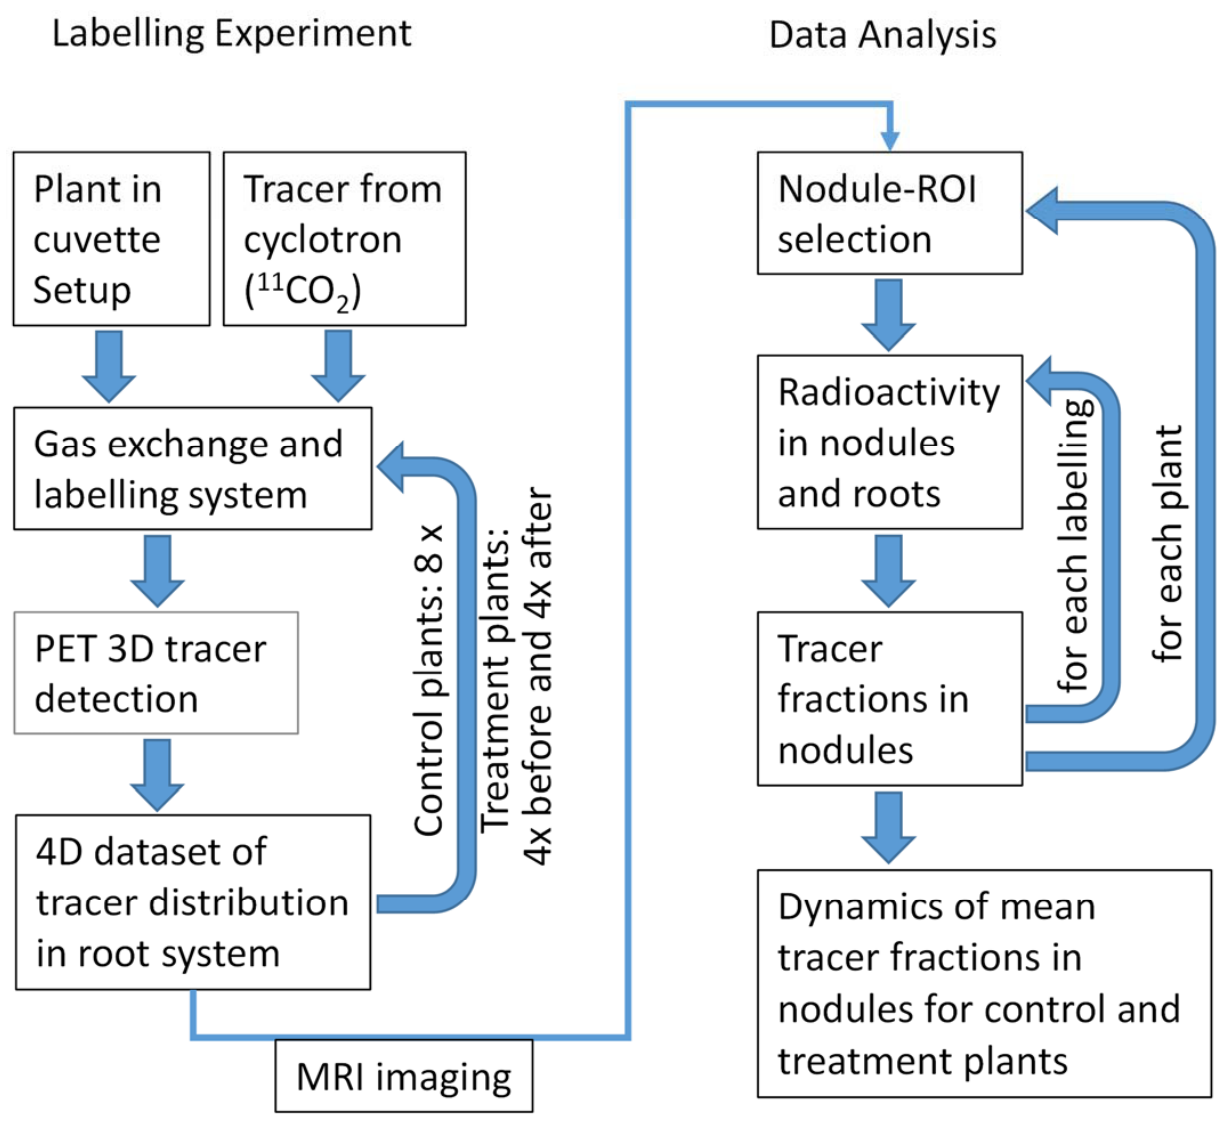
Figure 1. Flowchart of 11 C ‐ PET experimental and data analysis pipeline.